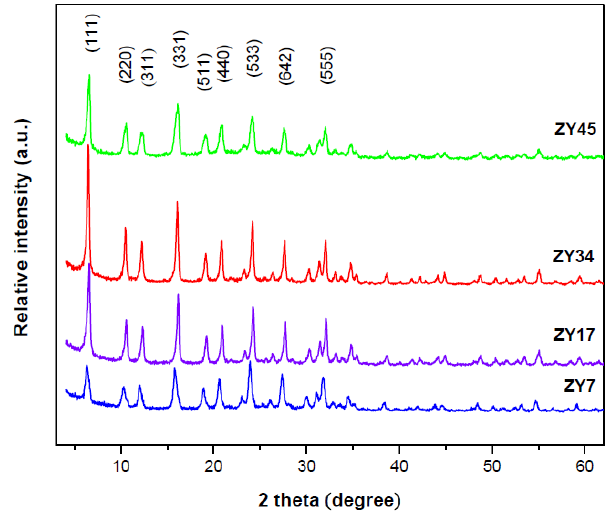
Figure 1. X-ray powder diffractograms of the Y-type zeolites. The average crystal (L) was estimated from the reflection of the plane (331, considering the Scherrer equation. The average crystal sizes were 19.6 nm, 31.4 nm, 31.2 nm, and 16.1 nm for the ZY7, ZY17, ZY34, and ZY45 zeolites, respectively. Similar results were reported for a series of steam-dealuminated Y-zeolites [30]. The UV-vis spectra of the Y-type zeolite samples (Figure 2a) showed a main band between 280 and 285 nm. The decrease of the Al content in the samples produced a reduction of the absorbance. The band is attributed to the charge transfer of the π p- π d transition between oxygen species (O 2 − ) and tetrahedral aluminum (Al 3+ ) of the zeolite structure [31]. The presence of extra-framework Al cations was evidenced by the extension of the band up to 350 nm, as reported for other zeolite-type solids [31,32].